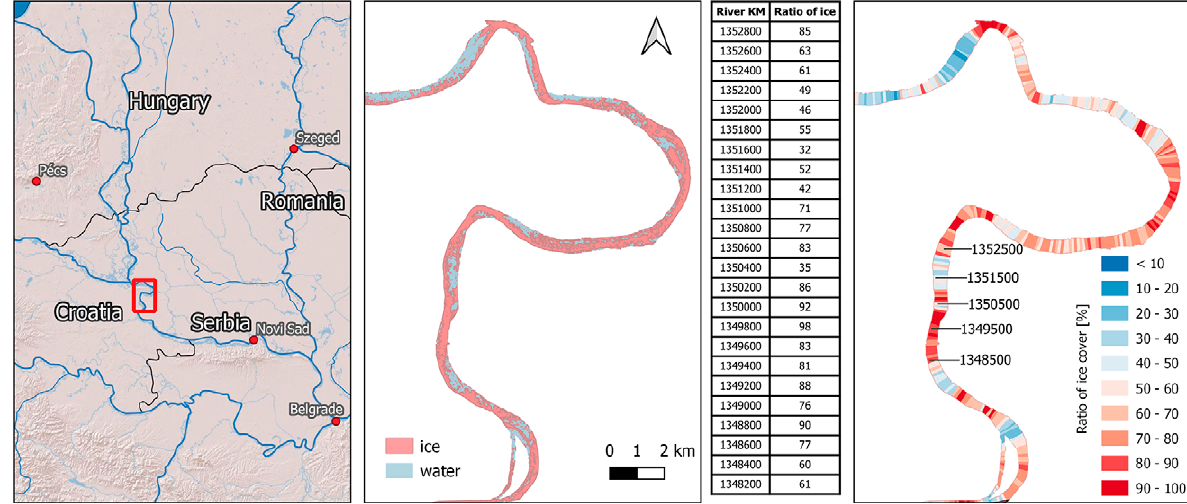
Figure 5. Results of the radar based ice coverage calculation of January 10, 2017 for a Danube river subsection in Croatia (left), the 10 x 10 metre resolution ice coverage (middle) and the polygon map showing the ratio of the river covered with ice per 100 metre section